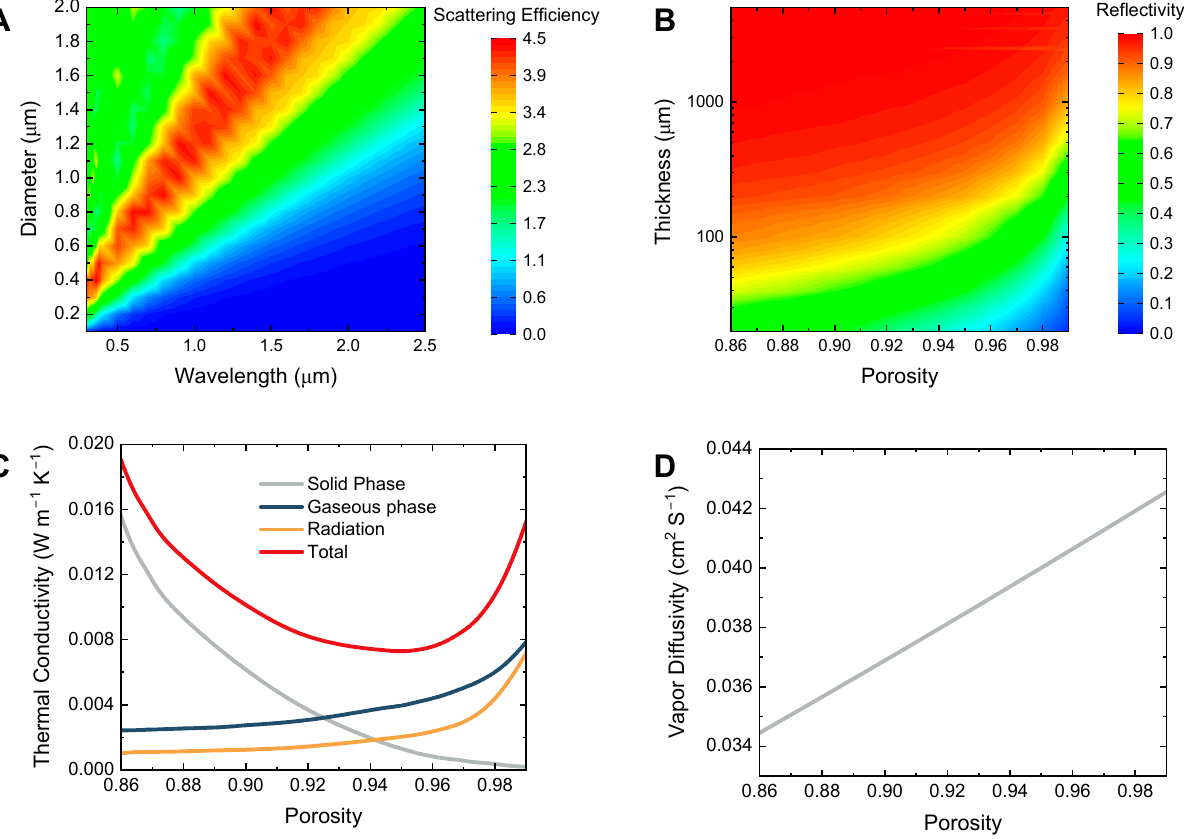
Figure 5. Parameters of aerogel layer response to its microstructure. Simulated scattering efficiency ( A ) and solar reflectivity ( B ) based on the optical model. Calculated thermal conductivity ( C ) and vapor diffusivity ( D ).